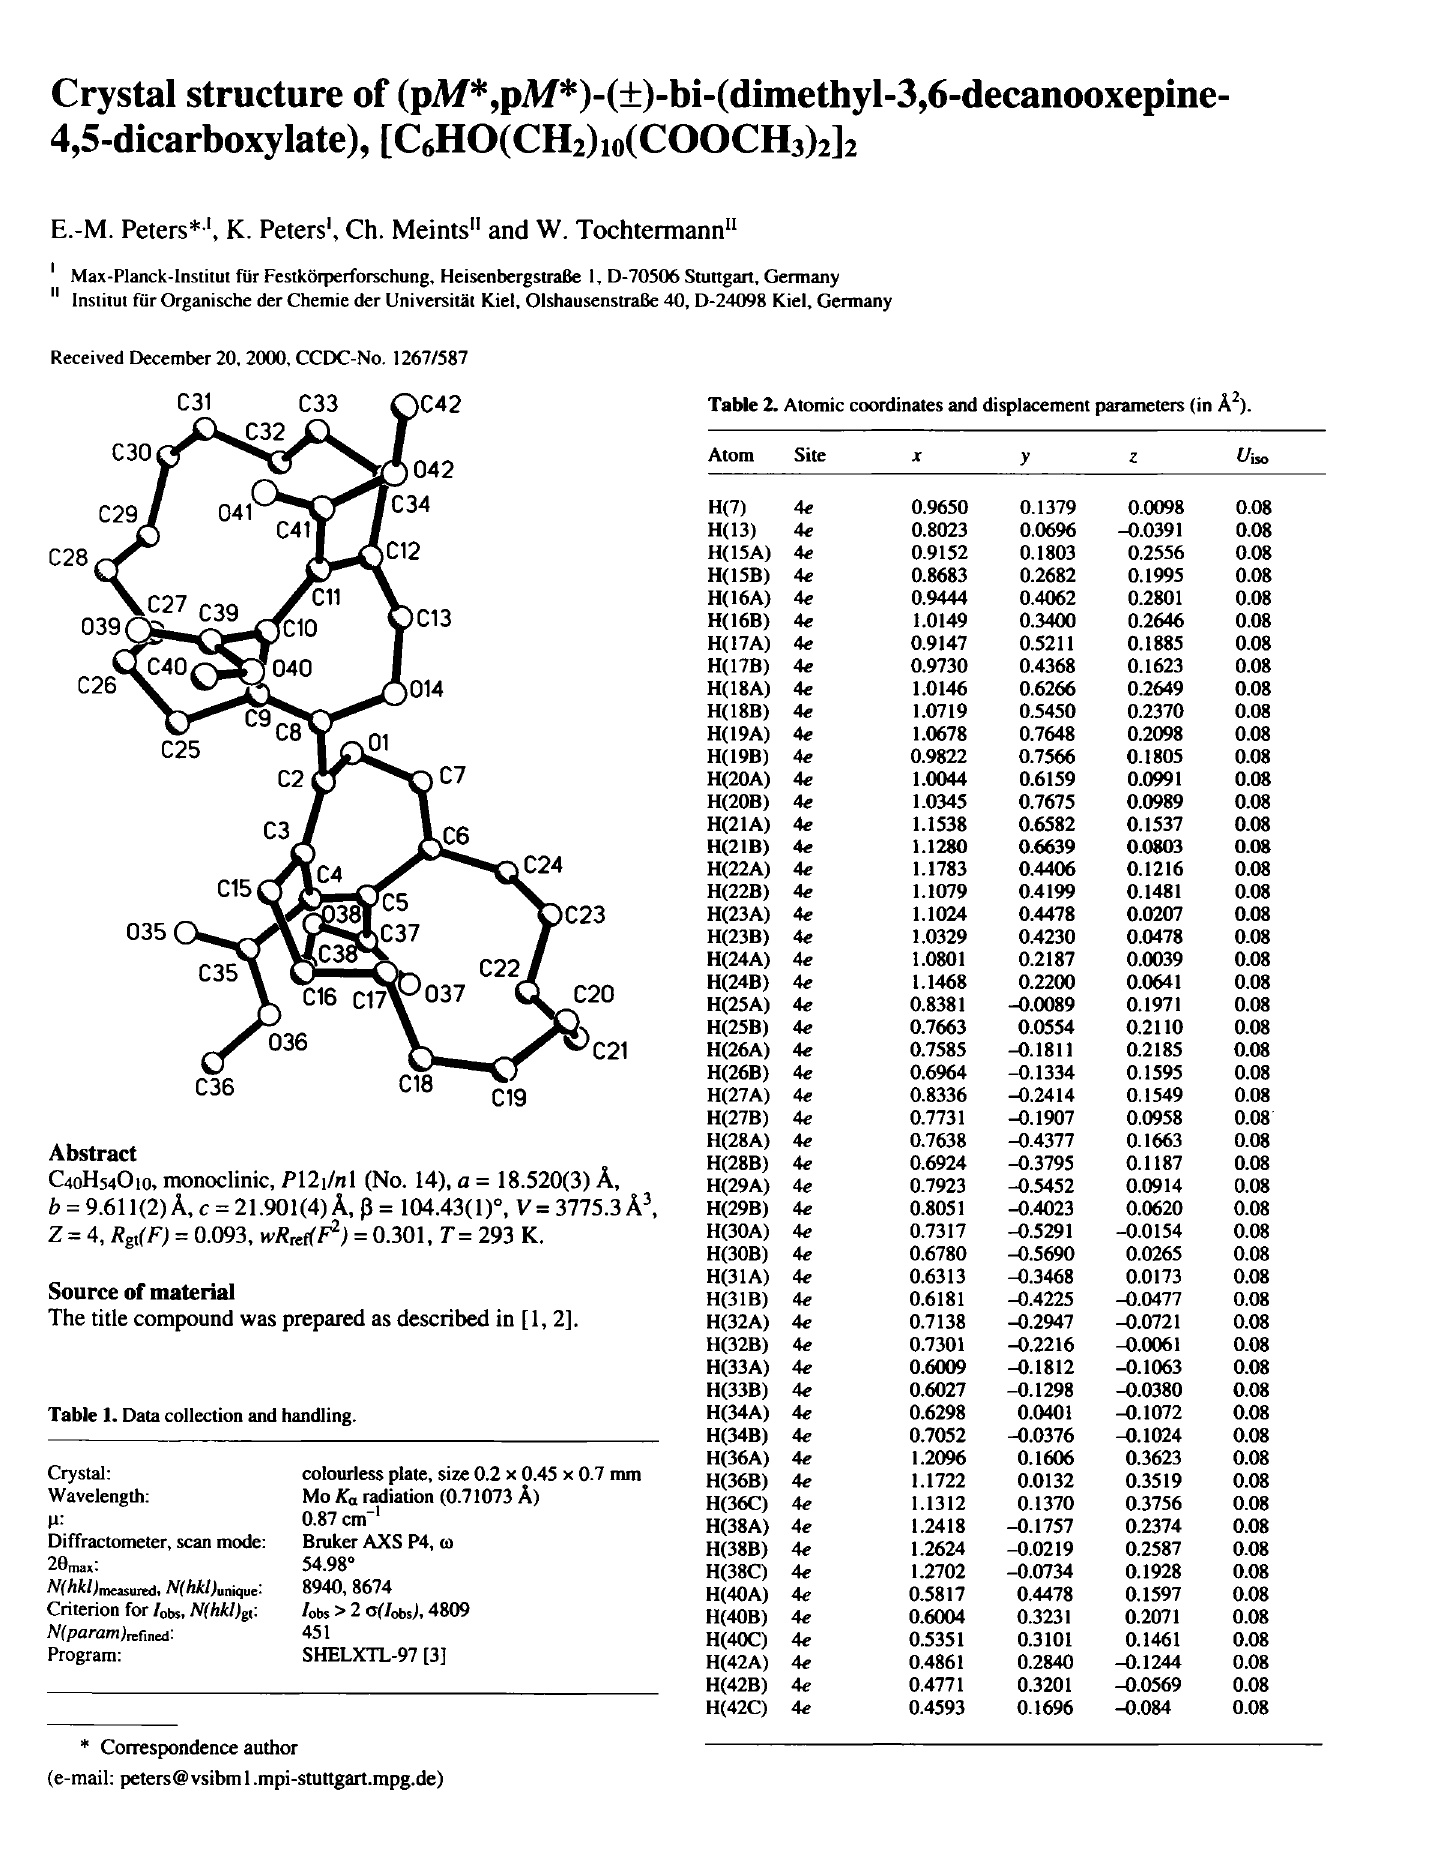
Table 1. Data collection and